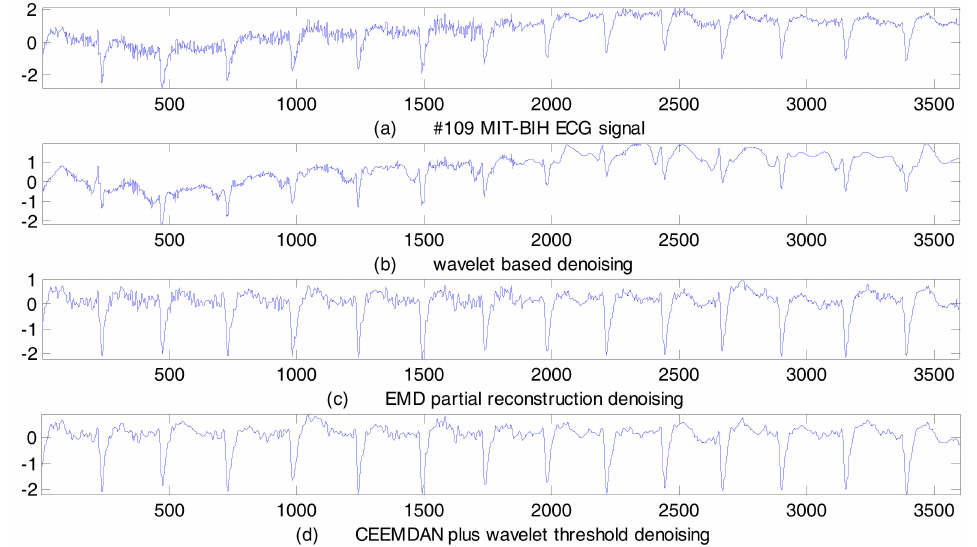
Figure 8. No. 109 MIT–BIH ECG signal de-noising